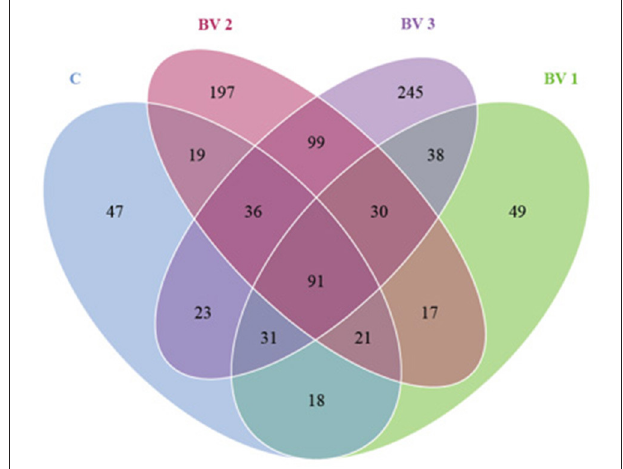
FIGURE 4 | A Venn diagram showing the unique and shared operational taxonomic units (OTUs) among groups of L. vannamei fed diets containing